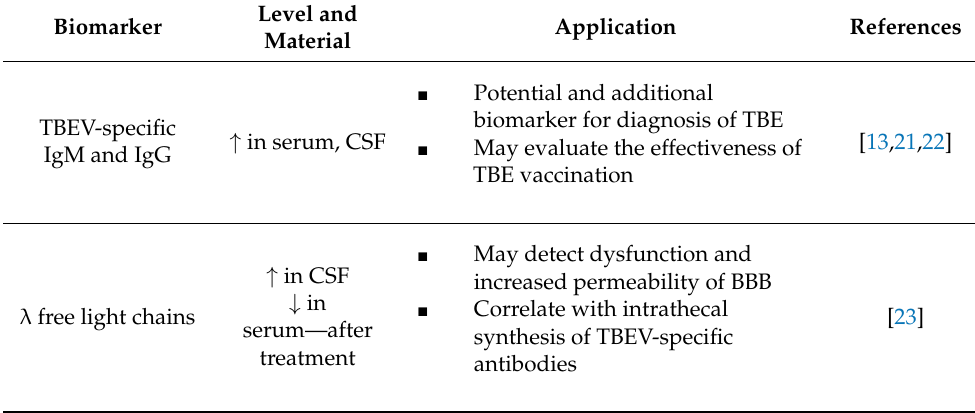
Table 1. Applications of selected tick-borne encephalitis